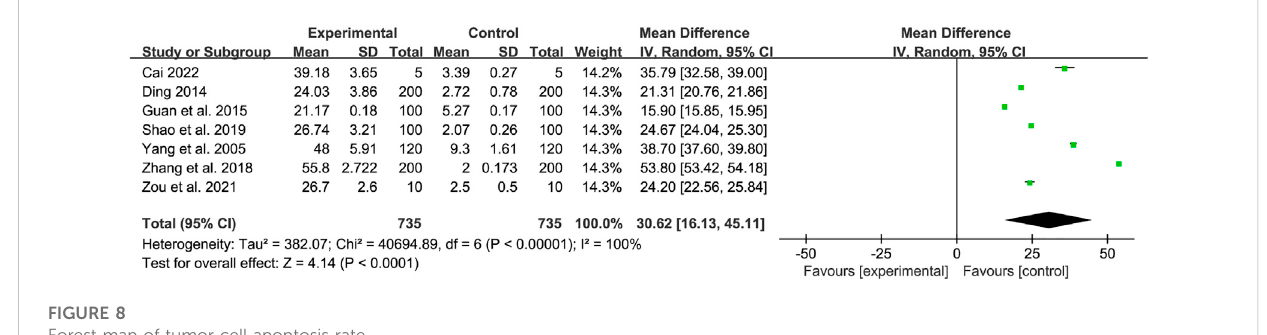
FIGURE 8 Forest map of tumor cell apoptosis rate.